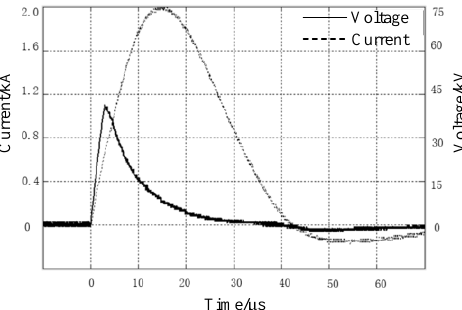
Figure 11. Images of modified soil with the SAP content of 0.5%: ( a ) Before breakdown; ( b ) front view; ( c ) side view; ( d ) top view.